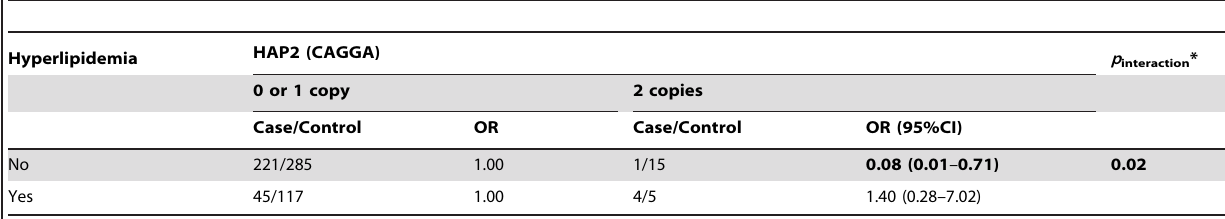
Table 6. Interaction between HAP2 and hyperlipidemia on AD risk.